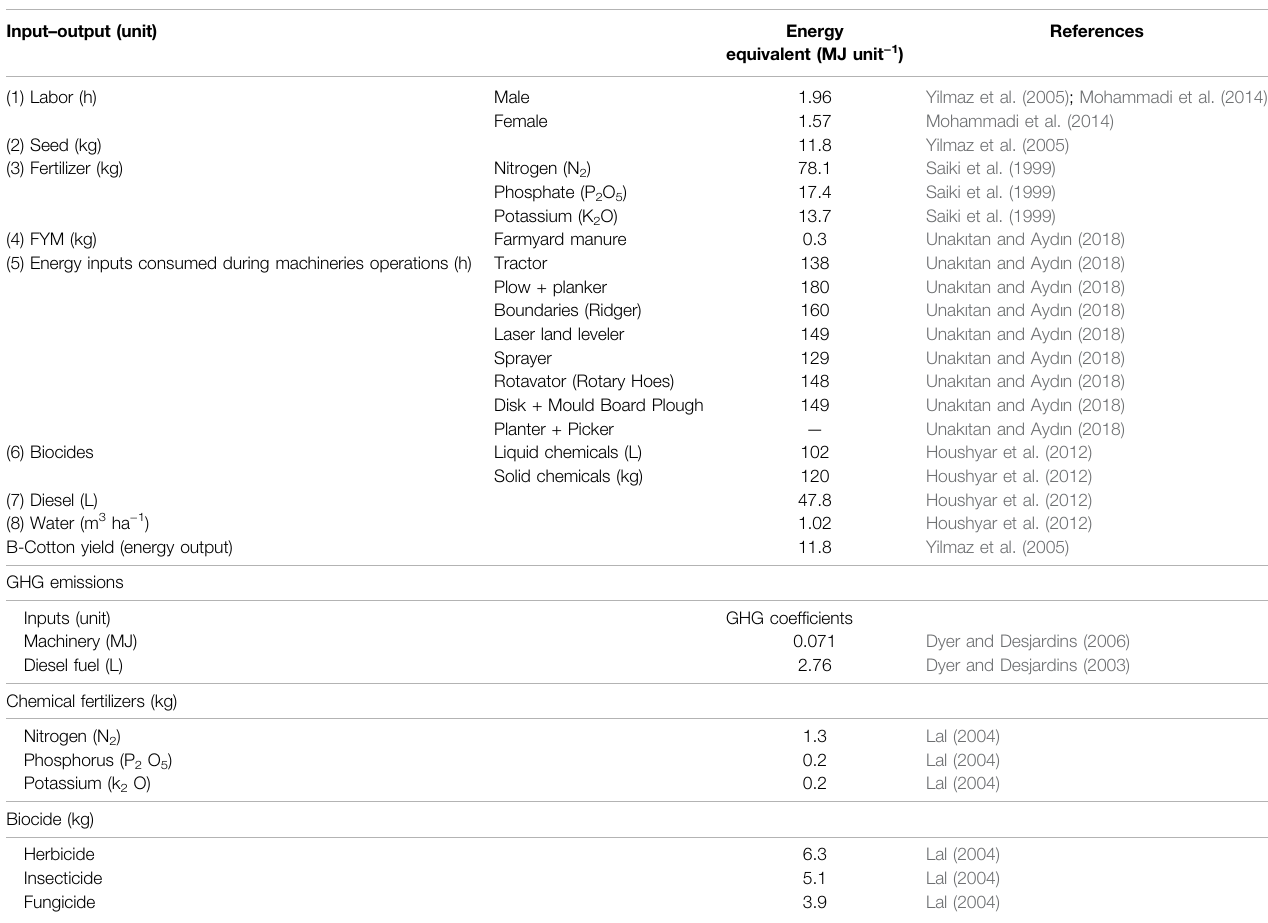
TABLE 1 | Energy and GHG